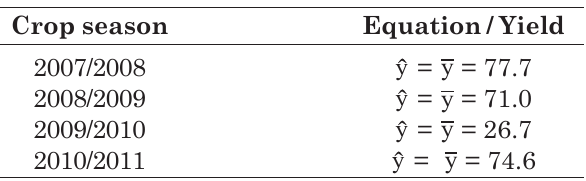
Table 3. Coffee yield ( y , bag ha -1 ), as dependent variable of different sources and application rates of P (kg ha -1 of P 2 O 5 ) over the period of four crop seasons